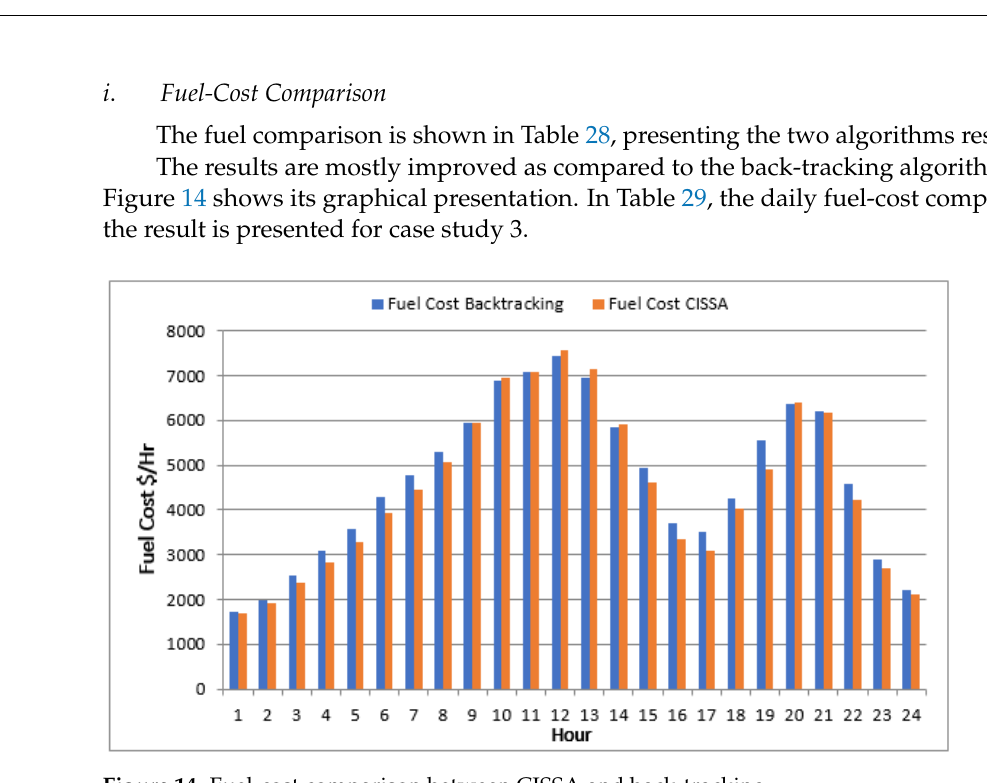
Figure 14. Fuel-cost comparison between CISSA and back-tracking. Table 29. Daily total fuel-cost comparison—case study 3.